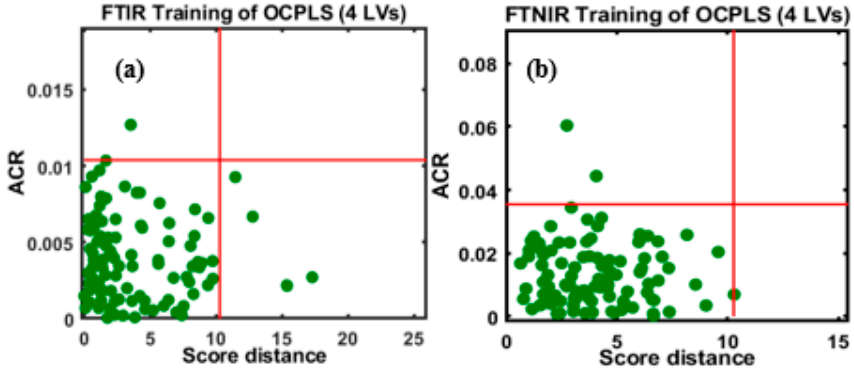
Figure 3. Standard deviation of residuals of one-class partial least squares (OCPLS) modeling vs. the number of latent variables in Monte Carlo cross-validation (MCCV) of OCPLS based on the FT-IR ( a ) and FT-NIR ( b ).